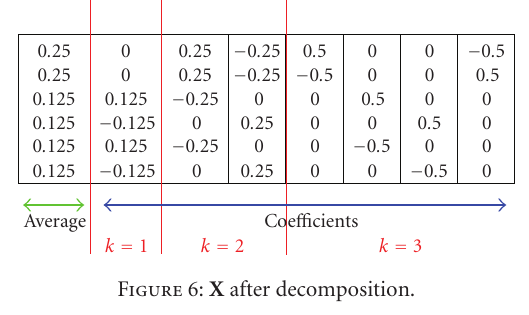
Figure 6: X after decomposition.